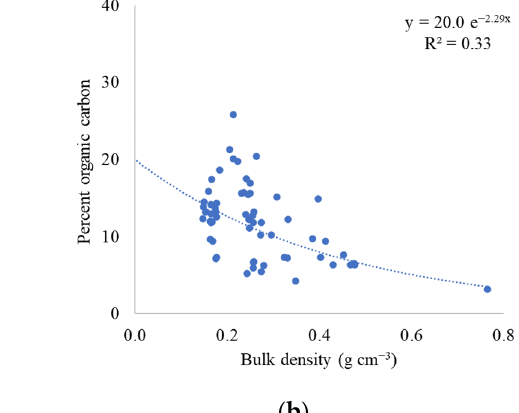
Figure 4. Regression predicting percent organic carbon based on soil bulk density in ( a ) 2013–2014 and ( b ) 2019 from all sites studied.